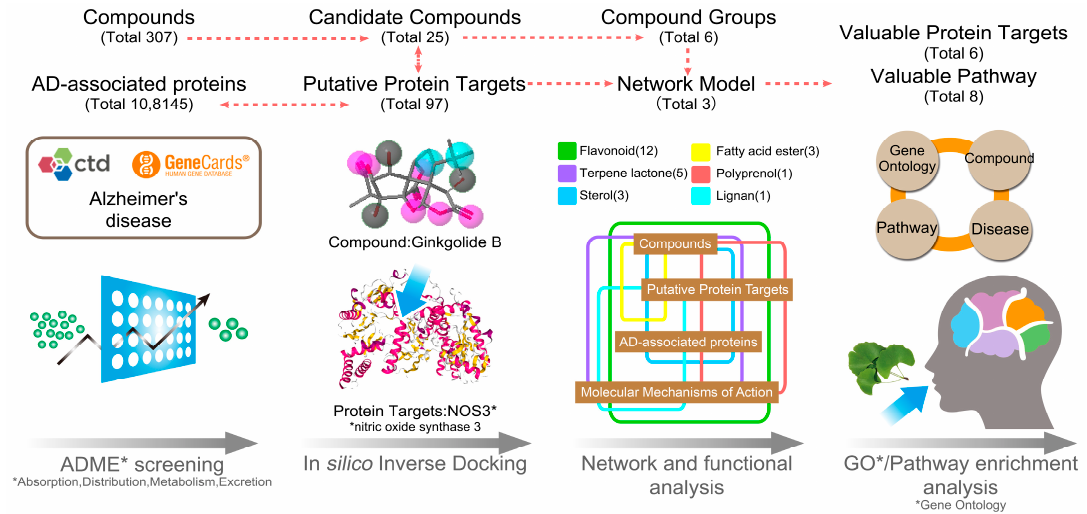
Figure 1. Methodology roadmap and summarized results for study.